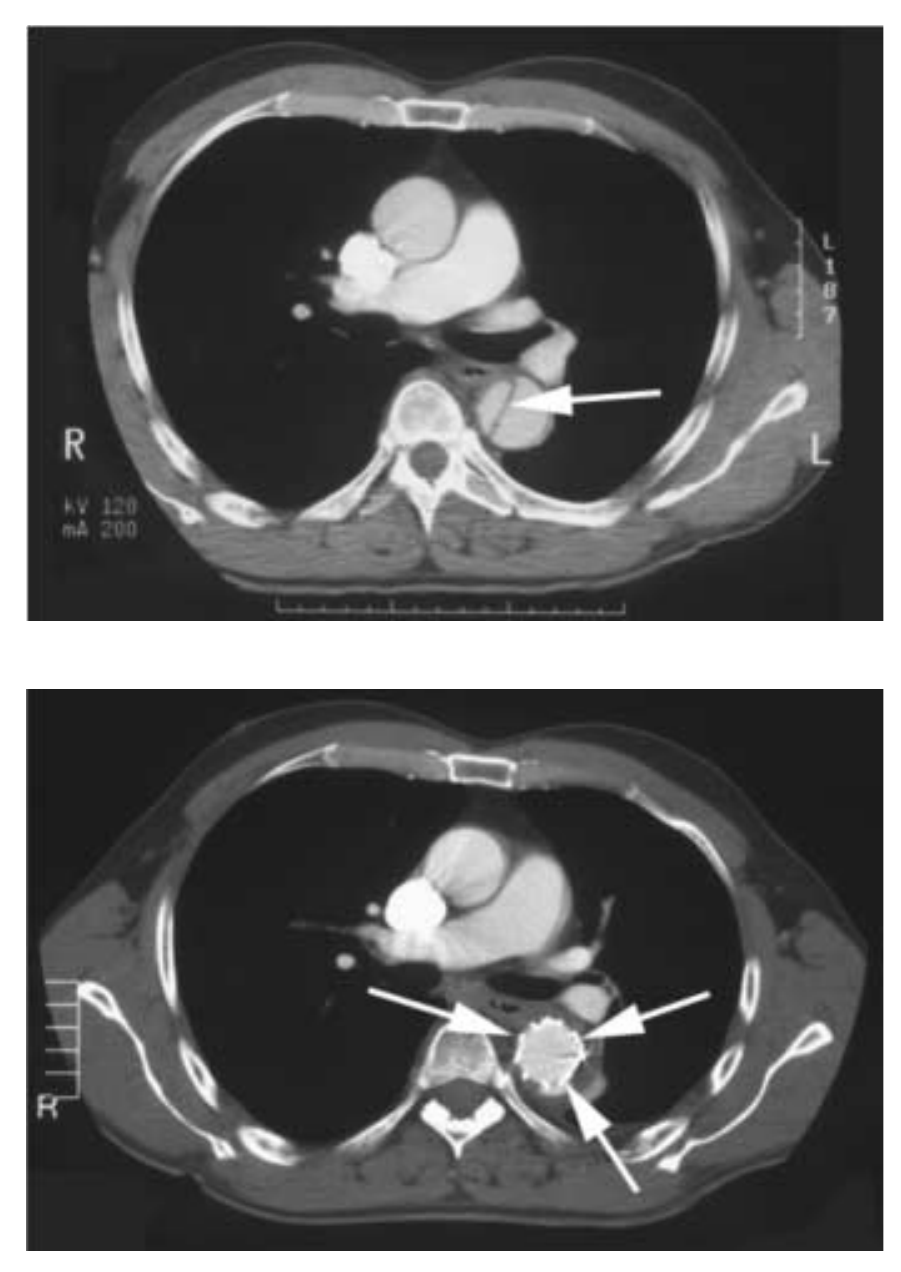
CT of acute type B dissection.